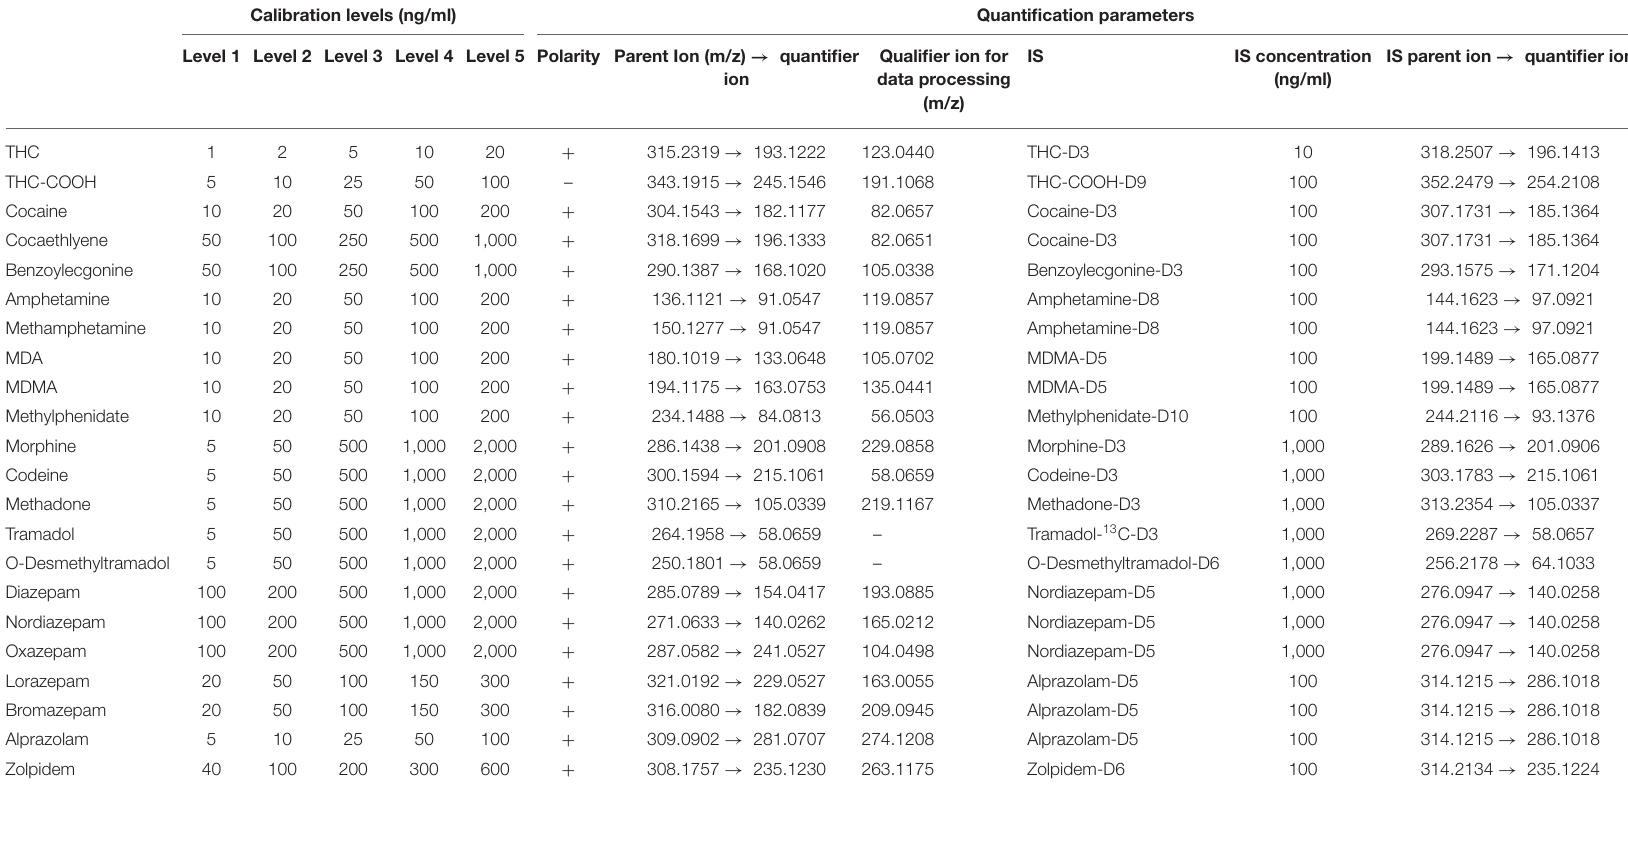
TABLE 1 | Calibration levels and quantification parameters (IS, polarity, parent ion m/z, and quantifier ions) for the substances of interest. The calibration ranges are in adequacy with the legal thresholds and the therapeutic ranges. Calibration levels